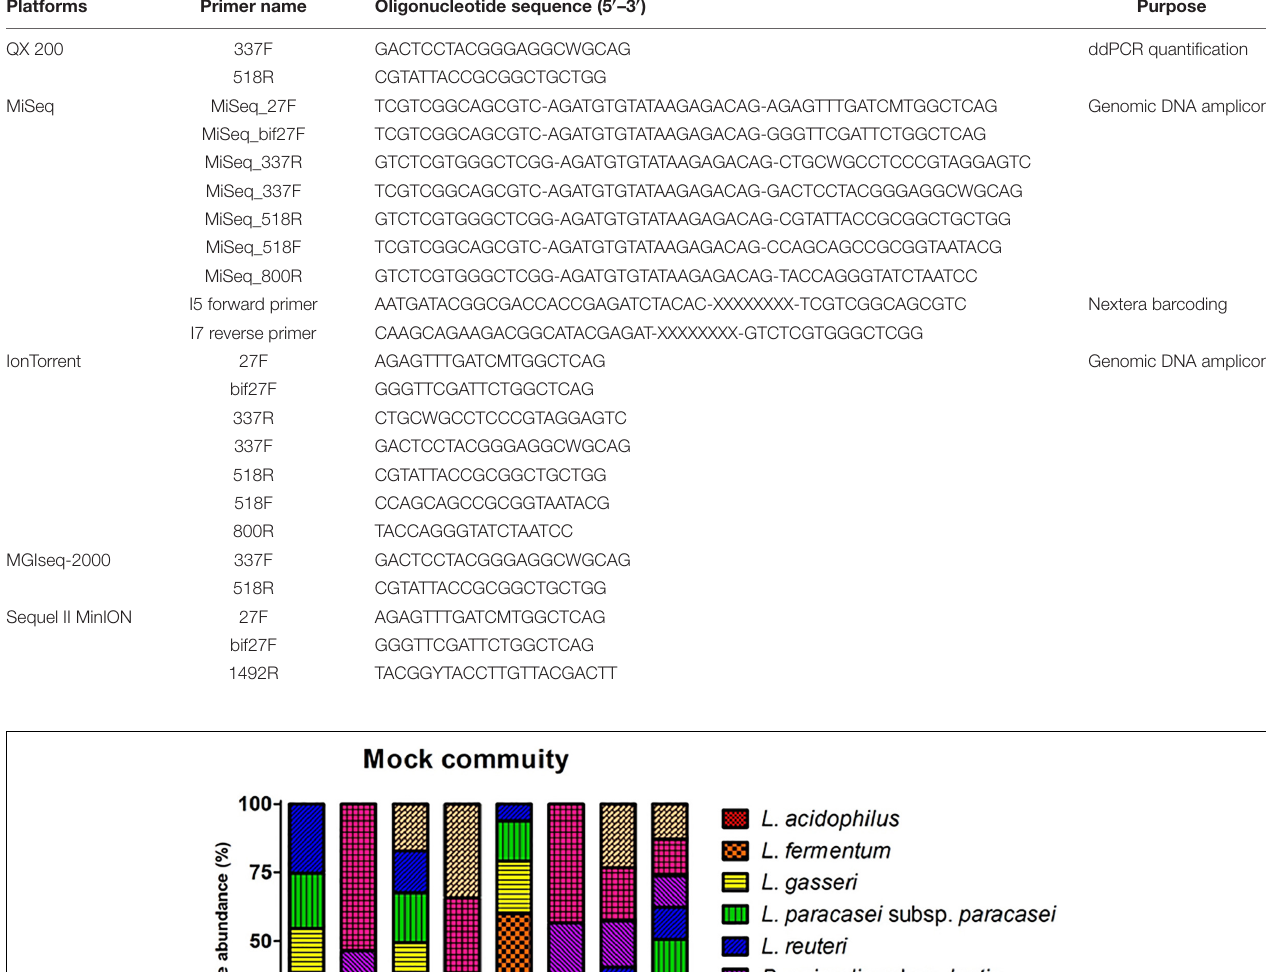
TABLE 2 | Primer sequence used for PCR, ddPCR, and NGS in this study. Platforms